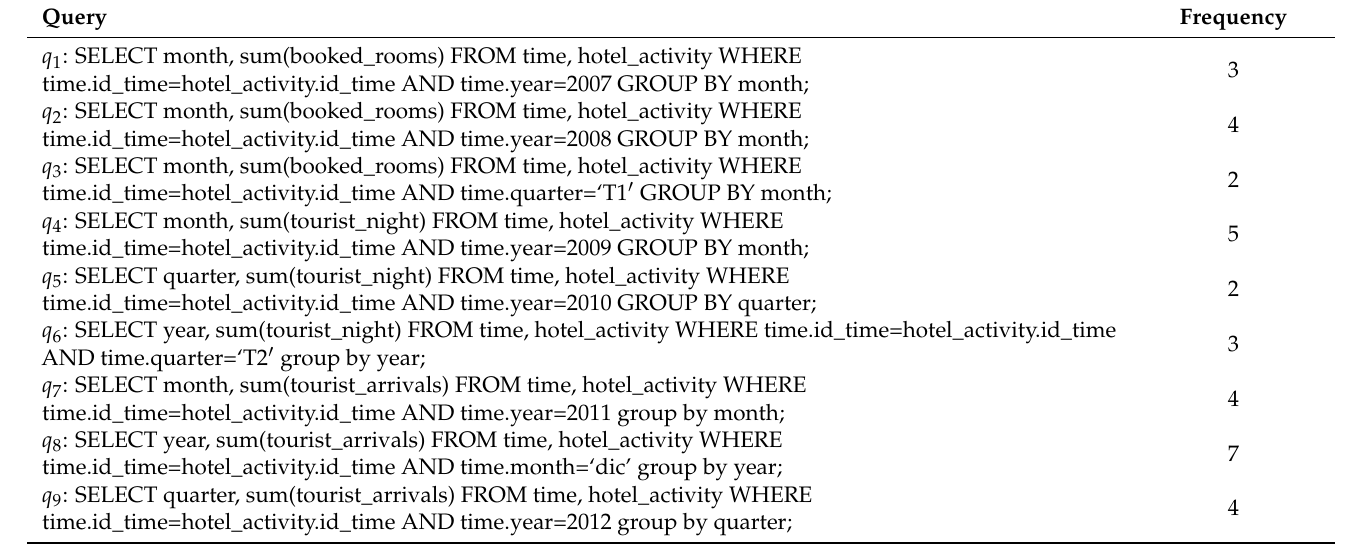
Table 13. OLAP queries executed in the tourist DW in the second experiment.